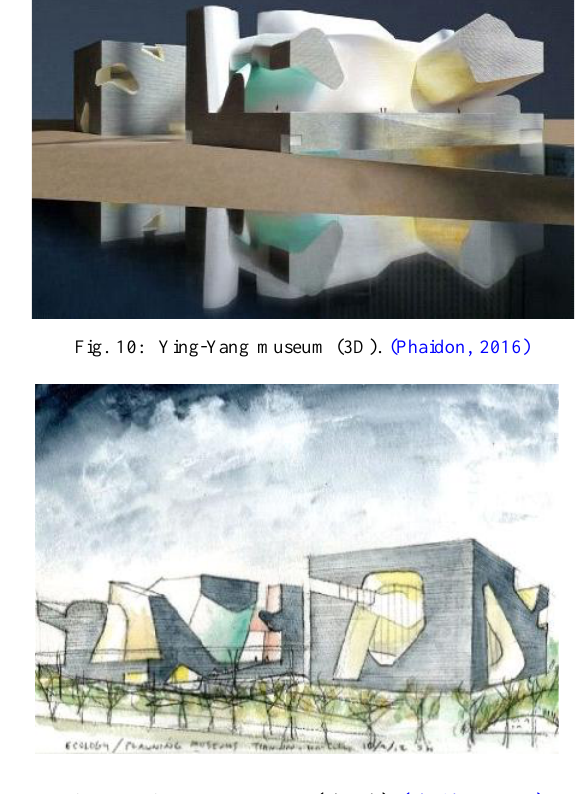
Fig. 11: Ying-Yang museum (Sketch). (Phaidon,